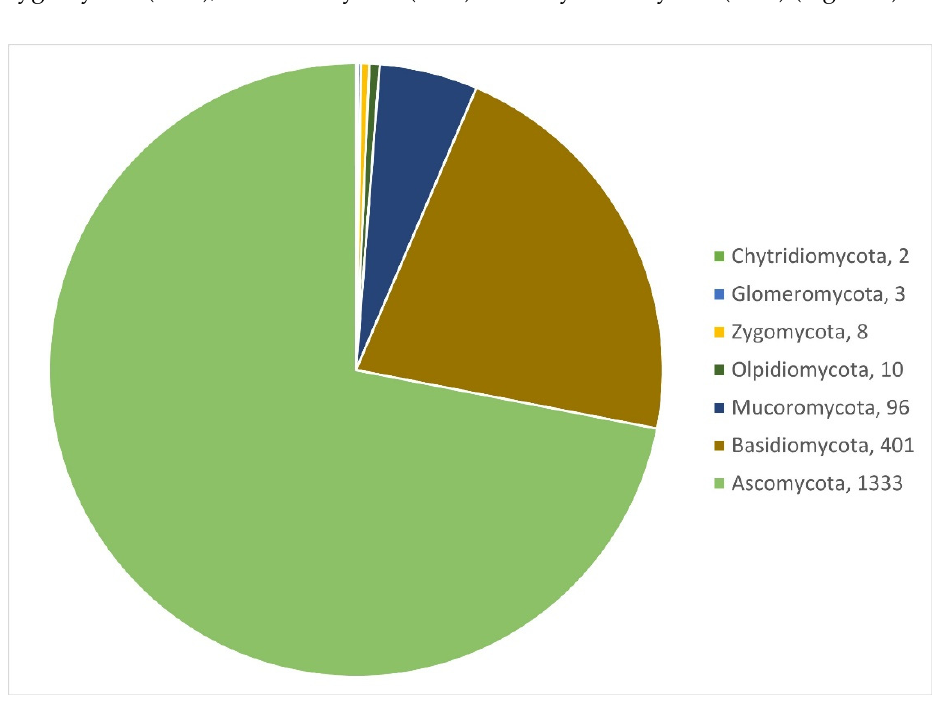
Figure 1. Fungal richness, number and proportional distribution of the 1853 fungal OTUs representing all the detected taxonomic phyla.